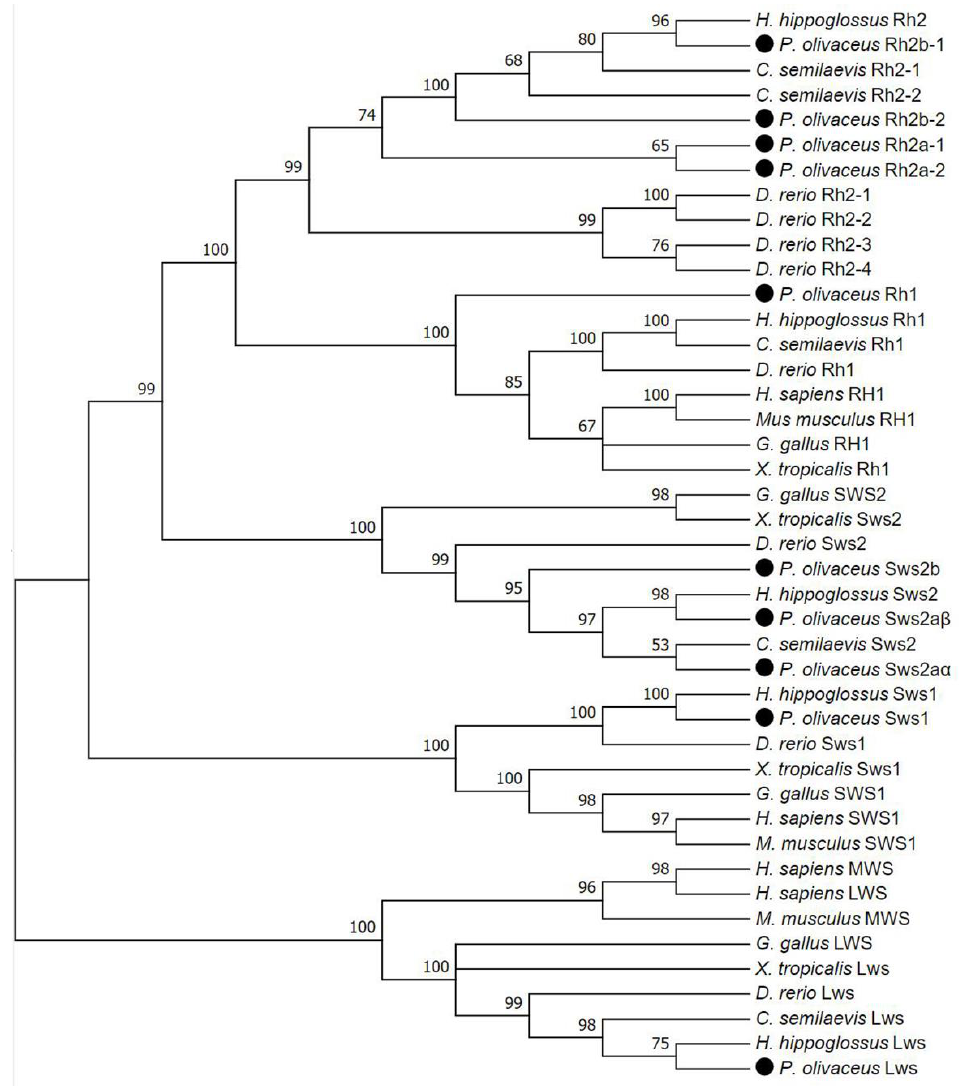
Figure 1. Evolutionary relationships of taxa. The accession numbers of the amino acid sequences of the five genes for analysis are as follows: Homo sapiens (RH1: NP_000530.1; MWS: NP_000504.1;